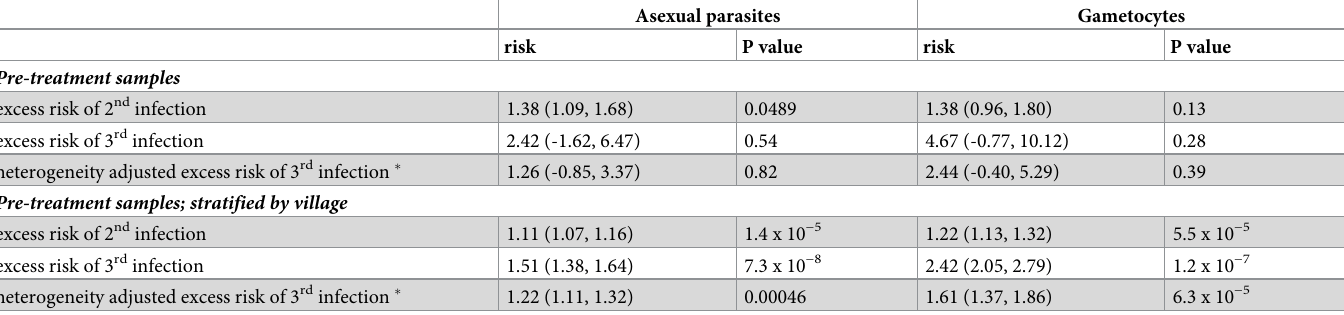
Table 1. Estimated risk of co-infection in pre-treatment samples. � The excess risk of triple infection accounting for the known pairwise clustering due to heterogeneity (e.g. 1.26 = 2.42/1.38 2